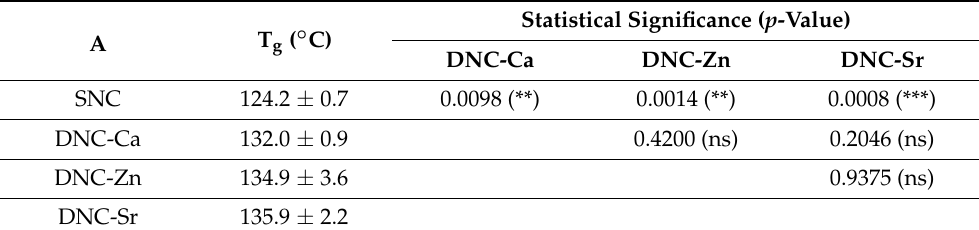
Table 4. (A) Glass transition (T g ) and (B) melting temperatures (T m ) of dual network composites chelated with Ca 2+ (DNC-Ca), Zn 2+ (DNC-Zn) and Sr 2+ (DNC-Sr) compared with the single network composite (SNC). Data are displayed as mean ± SD ( n = 3). Statistical significance was verified